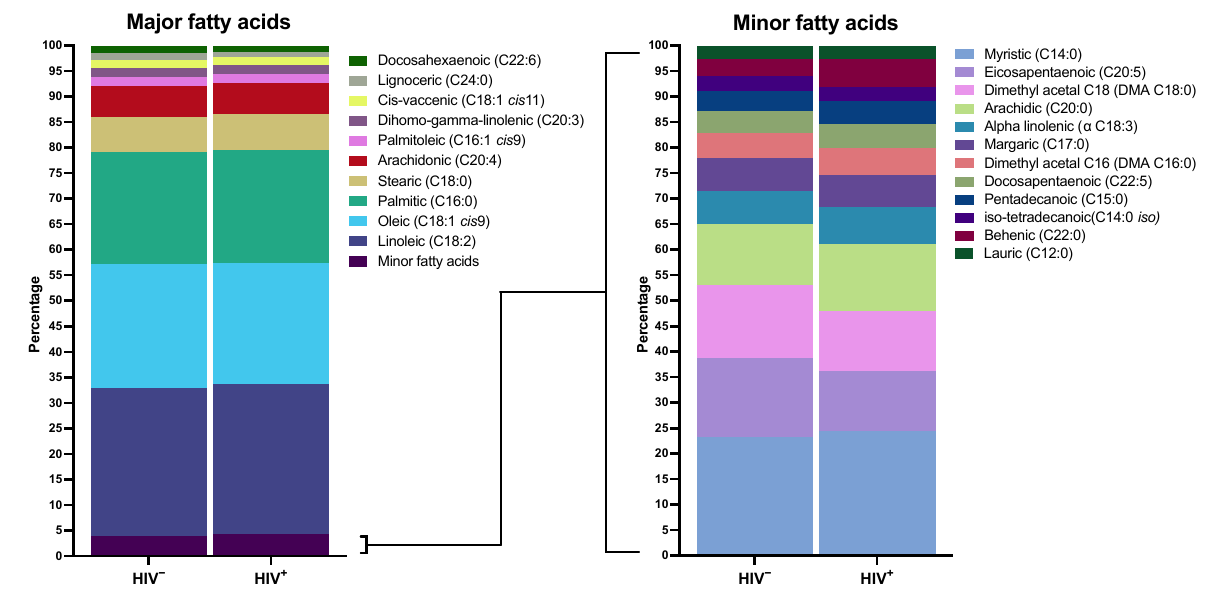
Figure 2. Distribution of fatty acid methyl esters in plasma. This figure shows plasma fatty acid distribution in participants with NAFLD and HIV infection and controls without it. The left panel shows major plasma fatty acid distribution in both groups. The right panel shows fatty acid distribution with lower plasma representation. Data are expressed as percentages, with a total sum of 100% in each population.